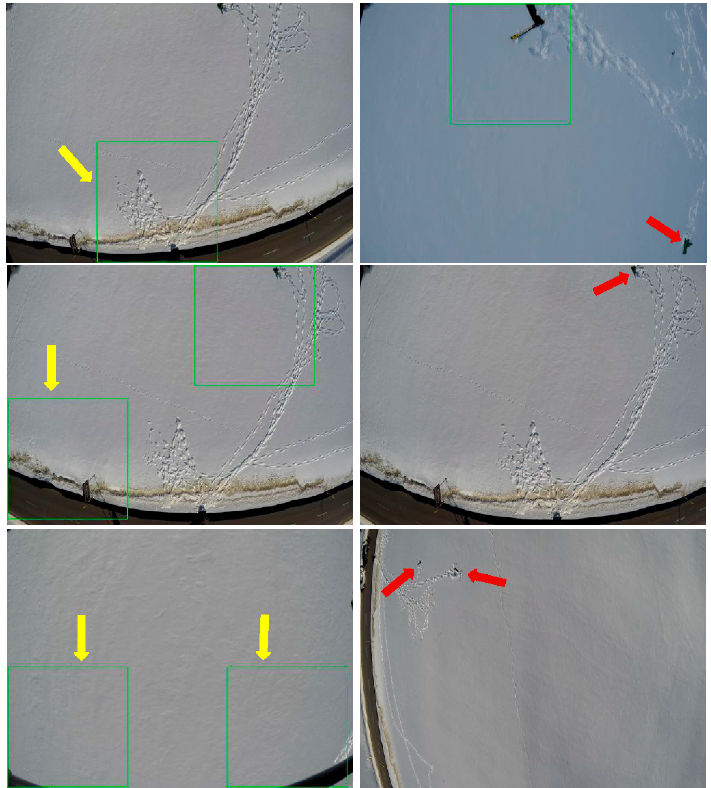
Figure 10. Examples of false positive ( left ) and false negative ( right ) frame snapshots at VGA resolution. Yellow arrows indicate false positive regions in a frame, whereas red arrows show missed objects in a frame.